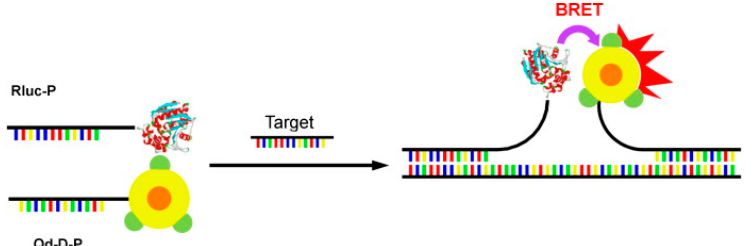
Figure 3. Schematic of BRET based on-type sensing system. The Rluc-P and Qd-D-P hybridized to the target in head-to-head fashion permitting BRET between Rluc and Qd. Reprinted from [55], with permission from Elsevier.